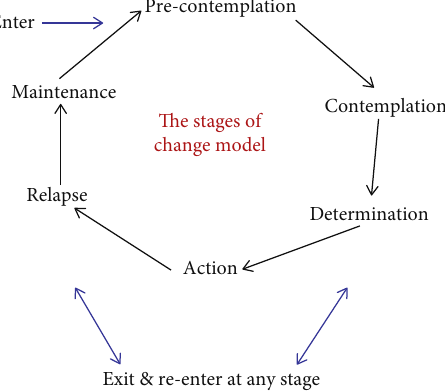
Figure 1: Transtheoretical model